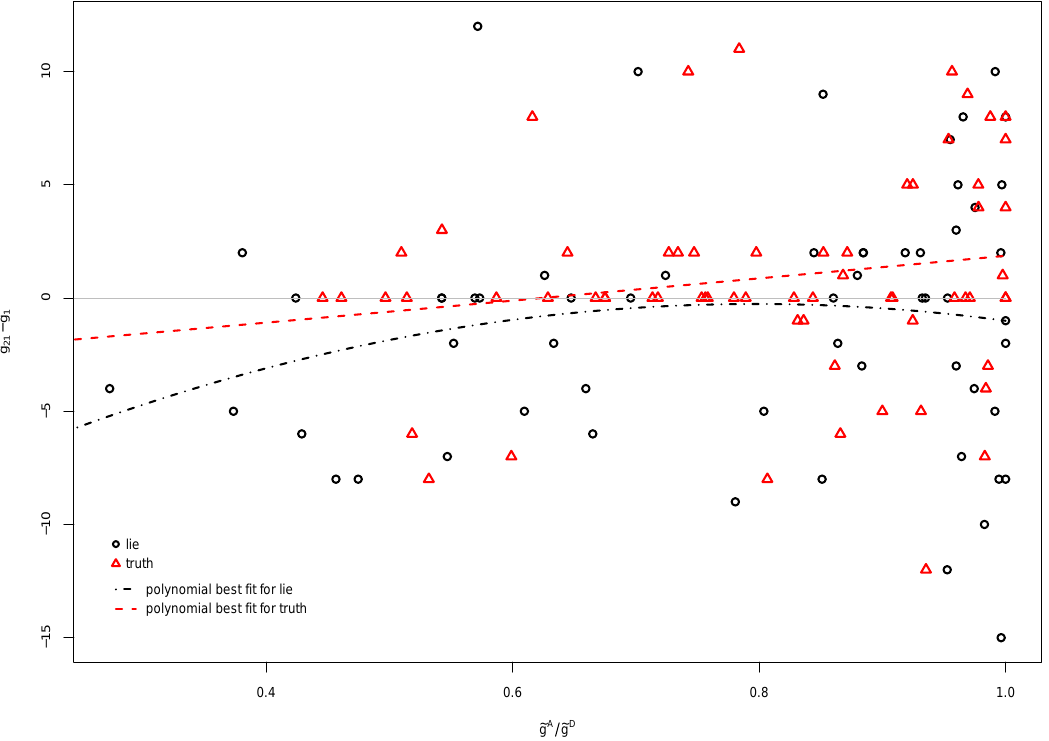
Figure 2. Differences between initial contributions in the second and first sequence related to ˜ g A − along polynomial best-fit-curves in LIE and TRUTH